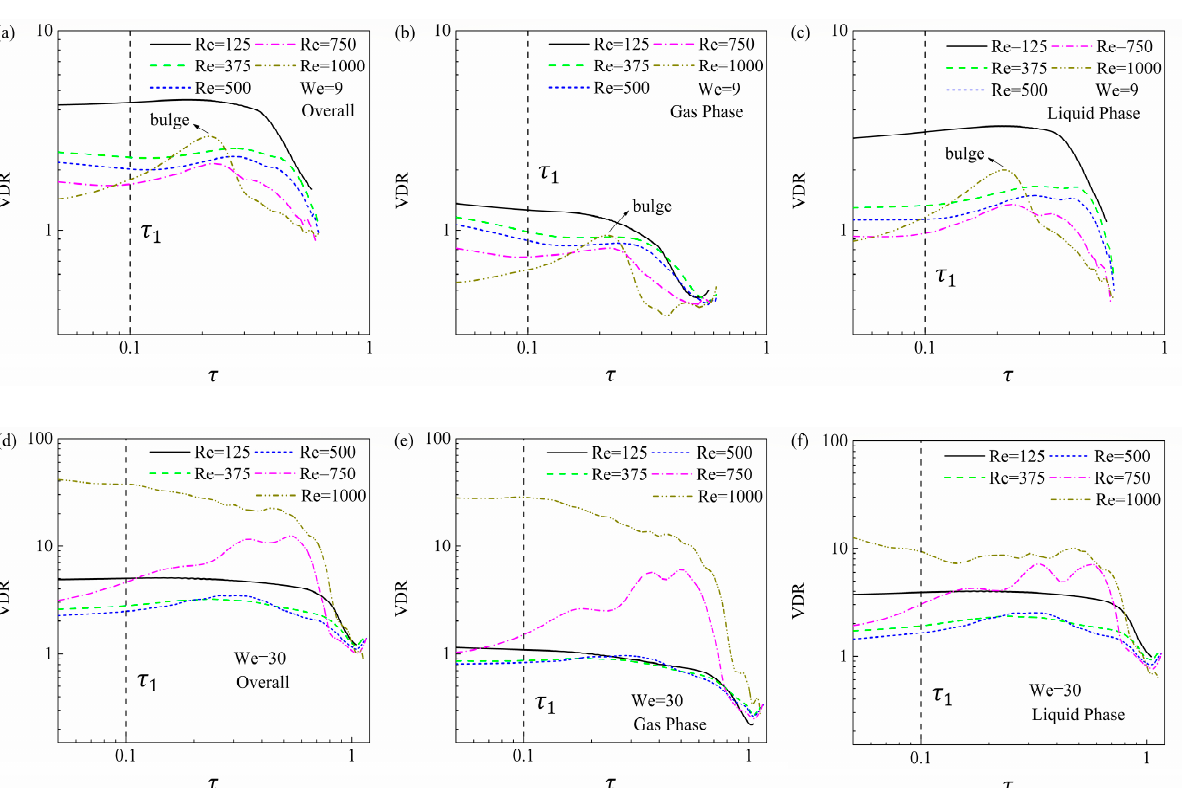
Figure 10. Viscous dissipation rate for droplet spread under different 𝑅𝑒 cases at ( a – c ) 𝑊𝑒 = 9 We = 9 and ( e – f ) We = and ( e – f ) 𝑊𝑒 = 30 .